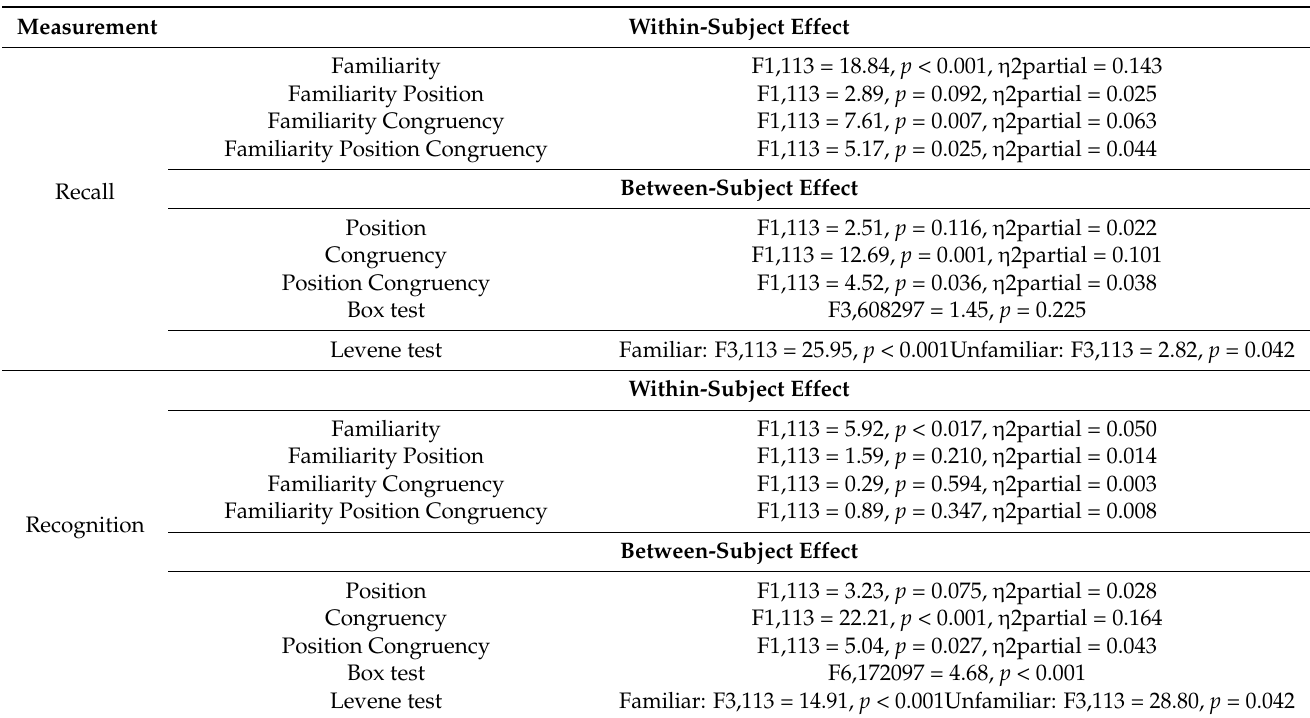
Table 4. Results of mixed ANOVA for recall and recognition based on the different experimental conditions. Measurement